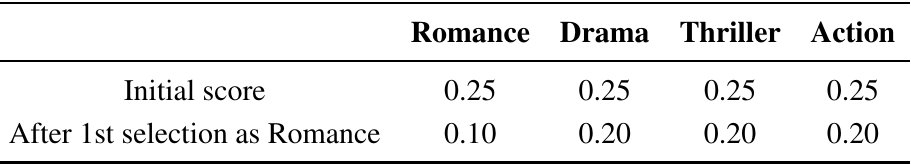
Table 6. User score for one person for different movie